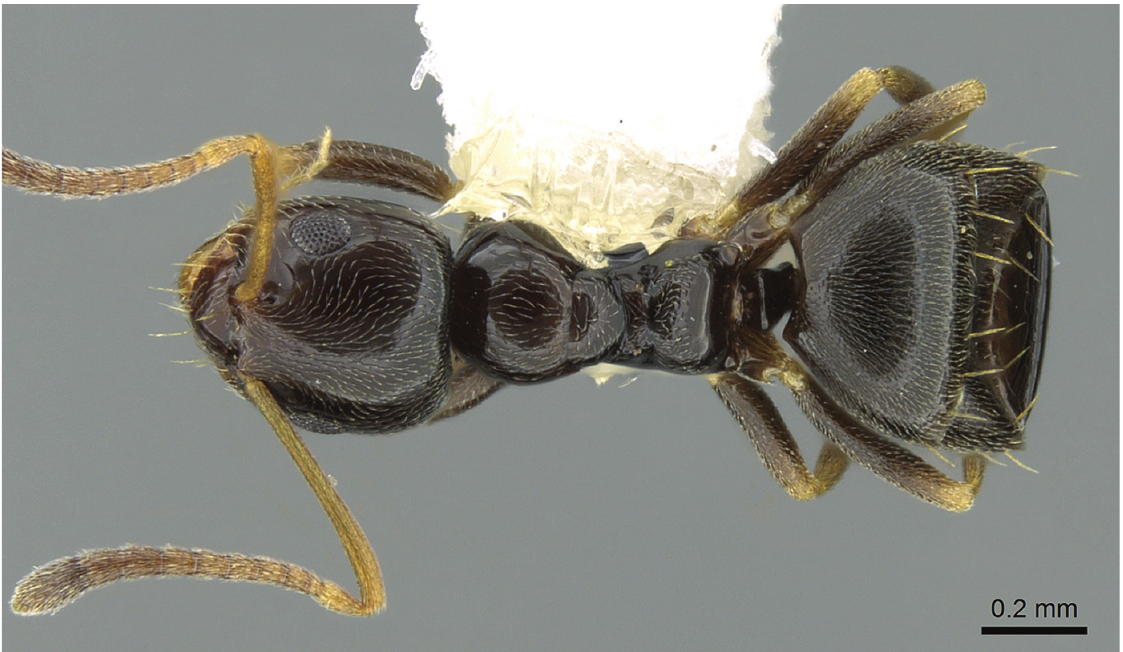
Figure 4. Dorsal aspect of a worker of Plagiolepis schmitzii (image from AntWeb 2020: CASENT0906252 , photographer E.